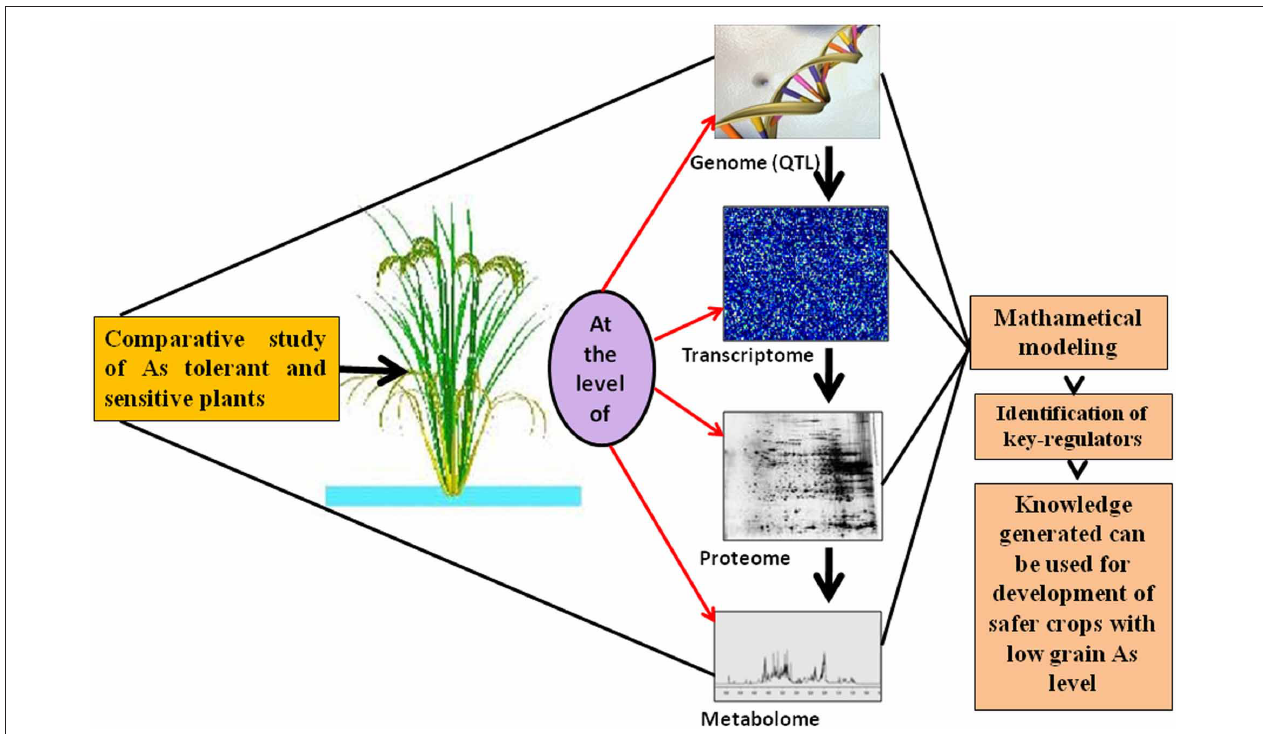
FIGURE 1 | Omics of As accumulation and tolerance: comparative study of As tolerant and sensitive plants at various levels such as genome, transcriptome, proteome, and metabolome to generate information to develop low grain As crops using breeding and molecular